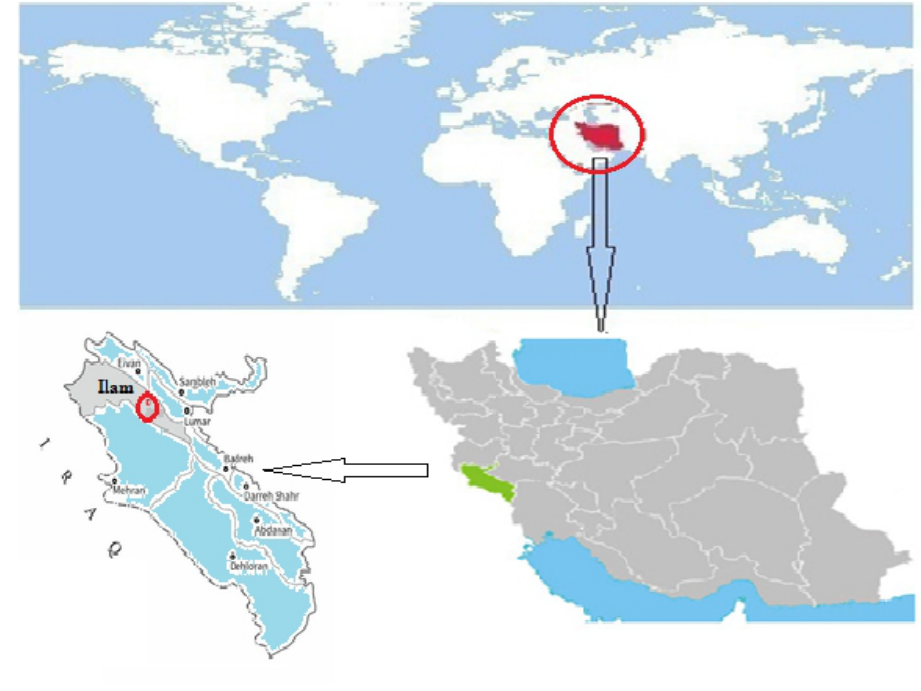
Fig. 1. Ilam location in the world and air quality monitoring stations in 2013 and